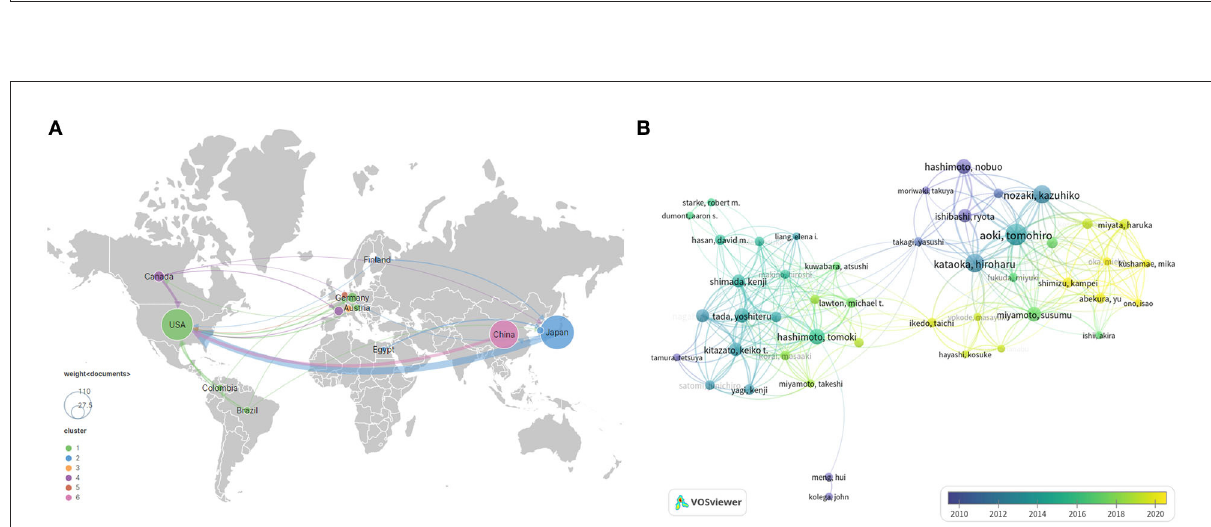
FIGURE4 International cooperation (A) and author cooperation network (B) identified by VOSviewer. Node size indicates the number of articles produced. The width of links positively associates with cooperation strength. The node color reflects the corresponding average appearing year according to the color gradient in the lower right corner, and dark blue or light blue represents studies that appeared relatively earlier, whereas green yellow or yellow represents studies active in recent